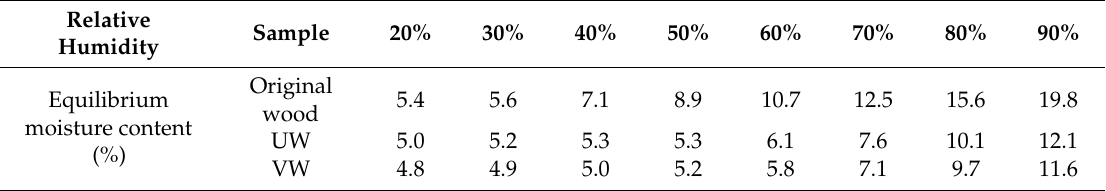
Table 4. Equilibrium moisture content of original wood, UW, and VW.